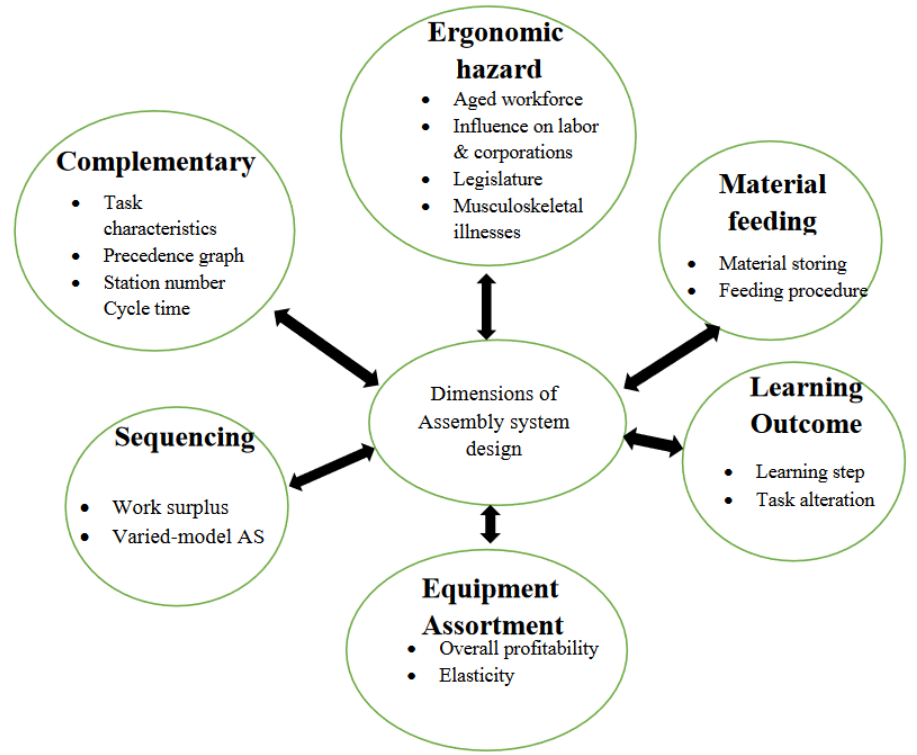
Figure 6. Dimensions of assembly system design.